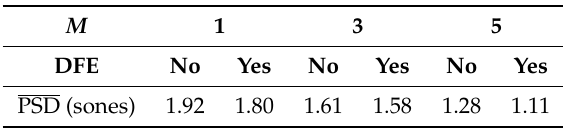
Table 3. Solid angle weighted mean values of PSD between reference HRTFs and Ambisonically rendered HRTFs for left and right ears.